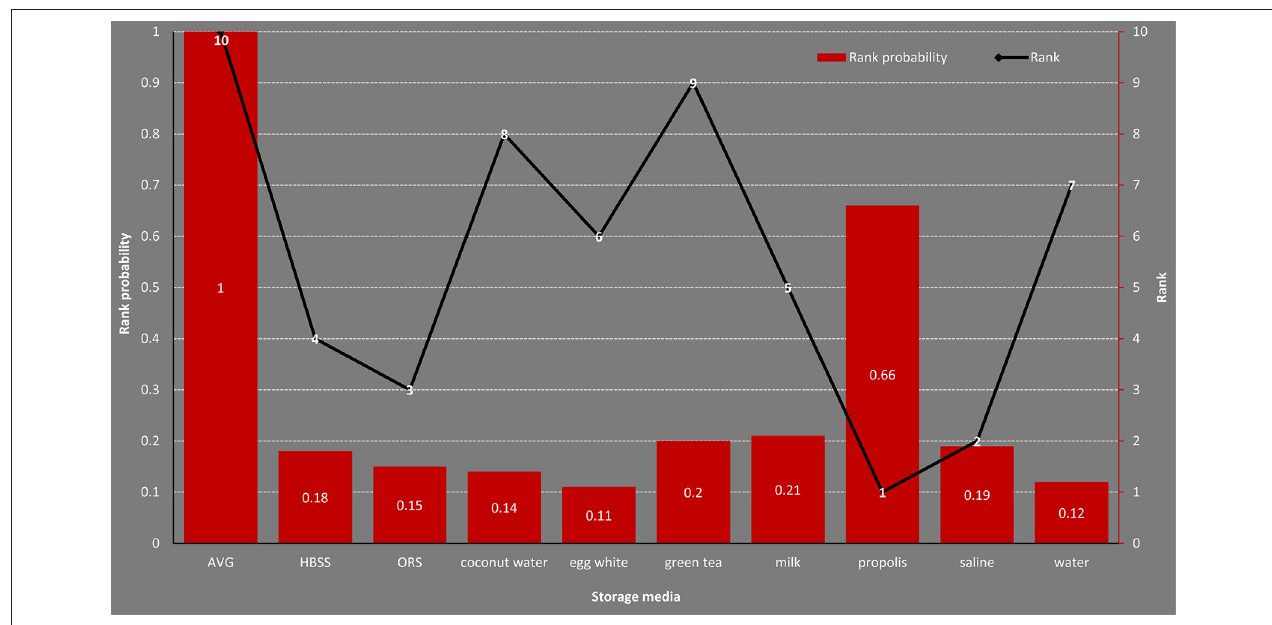
FIGURE 3 | Rank probability of all storage mediums for cell